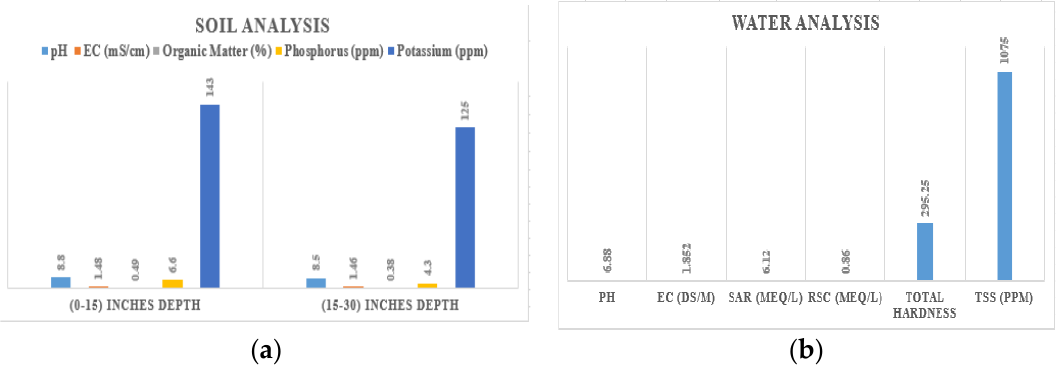
Figure 1. ( a ) Soil analysis, and ( b ) water analysis .